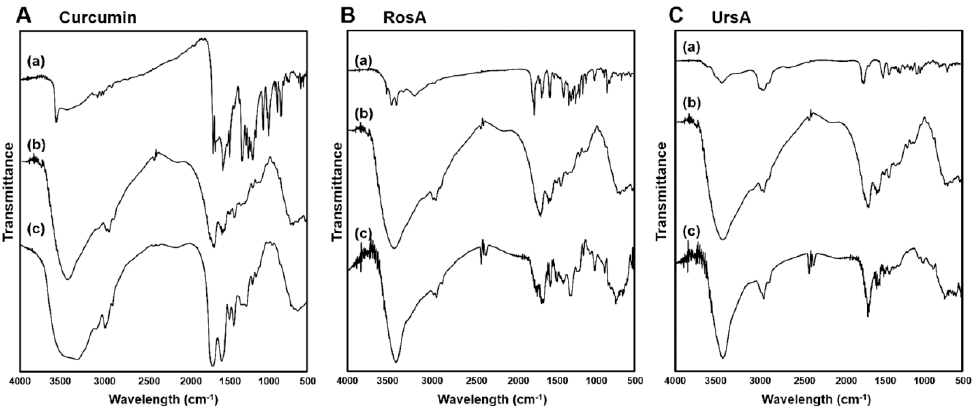
Figure 4. FT-IR spectrum with the BSA nanoparticles of ( A ) curcumin, ( B ) RosA, and ( C ) UrsA along with the data on pure compounds (drug or BSA powder) or physical mixtures.